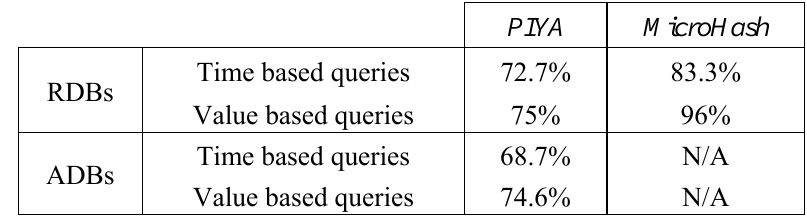
Table 8. Throughput per Second Optimization by PIYAS. Comparison to PIYA and